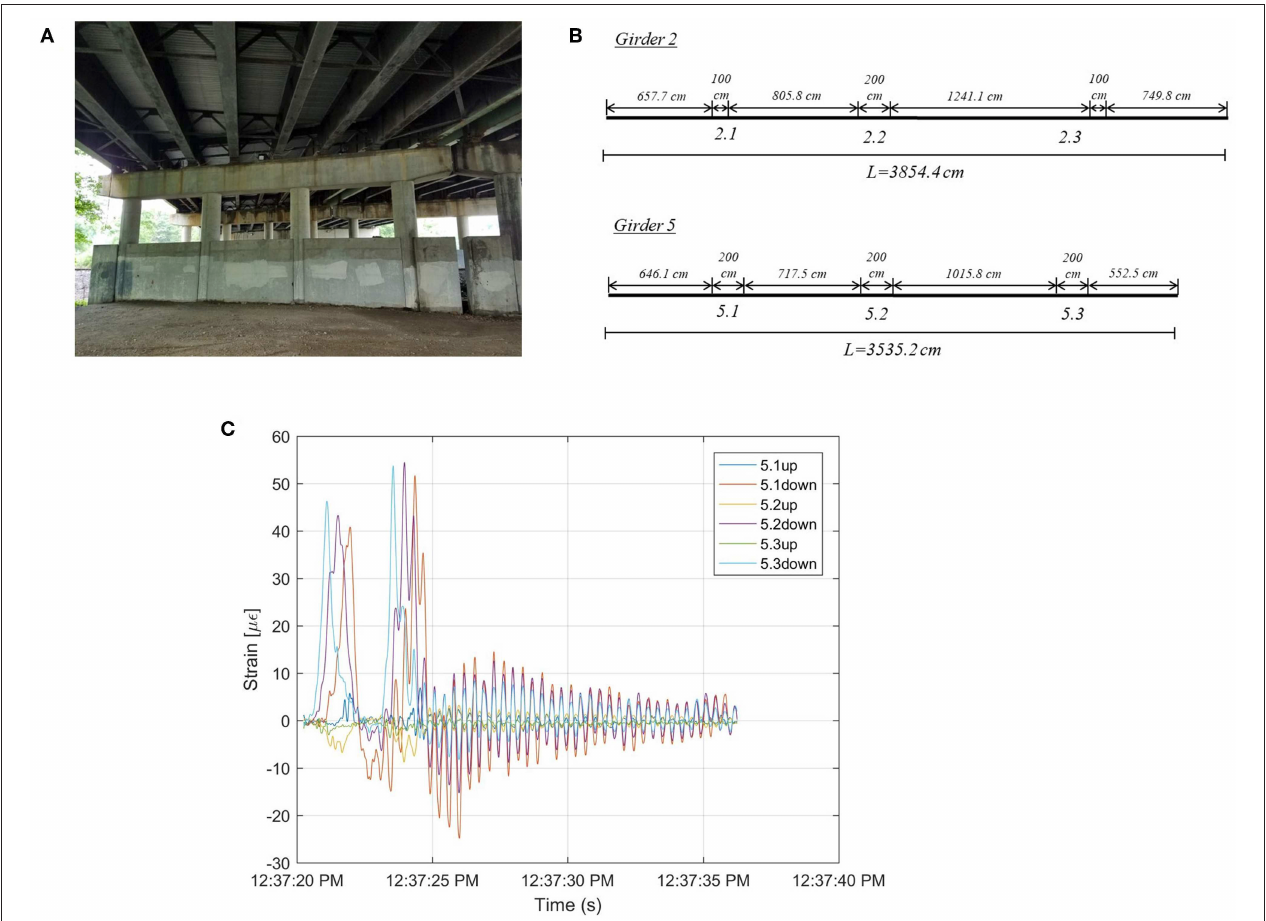
FIGURE 12 | (A) Underside of instrumented highway overpass, (B) the sensor locations and gage lengths for girder 2 and girder 5 on the structure, and (C) typical girder 5 strain response for the